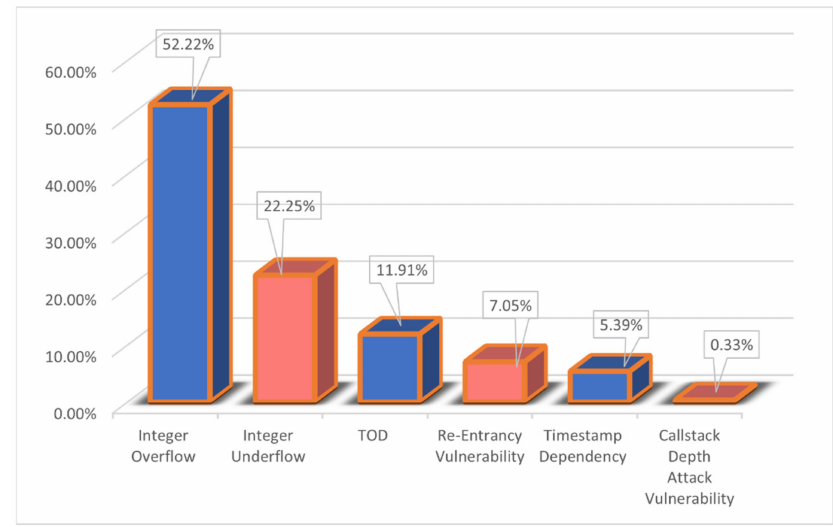
Figure 5. The final number of vulnerability contracts was collected.